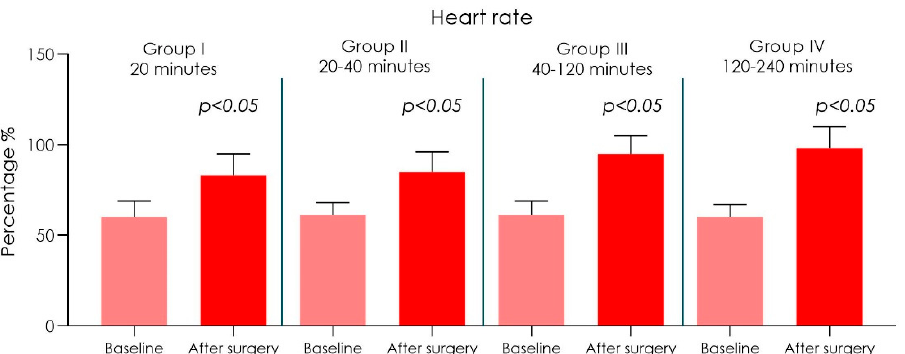
Figure 2. Graph chart of the surgeons’ heart rate (bmp) of Group I (20 min), II (20–40 min), III (40–120 min) and IV (120–240 min) (ANOVA post hoc Tukey HSD). No differences were detected between the baseline for both of Group I, II, III and IV. A statistically significant difference was detected by group comparison after the surgery procedure ( p < 0.05). I. Table 1. Summary of the surgeons O2 saturation (%) and heart rate (beats per minute-bmp) of Group I (20 min),